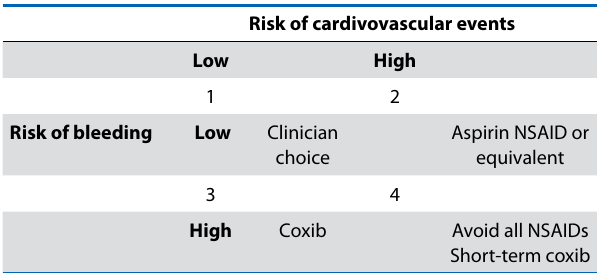
Table 1: Nonsteroidal anti-inflammatory drug selection based on risk of bleeding or cardiovascular thrombosis Risk of cardivovascular